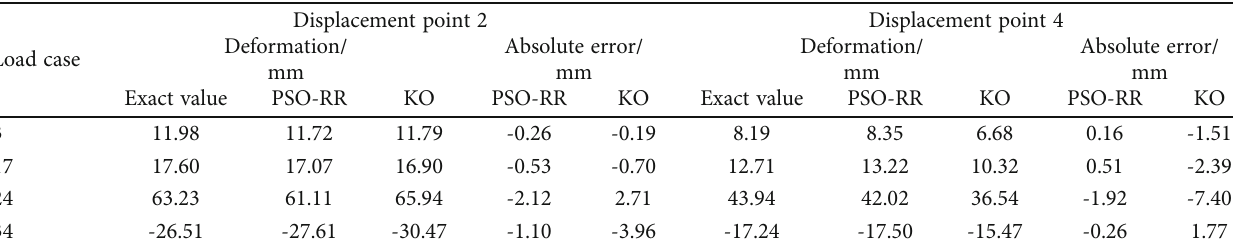
Table 4: Analysis of PSO-RR and KO theoretical prediction